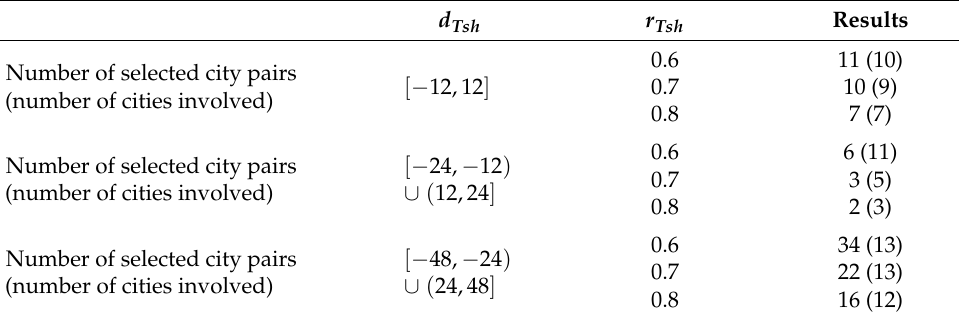
Table 2. Results of selected single cites and city pairs for different d Tsh and r Tsh . d Tsh r Tsh